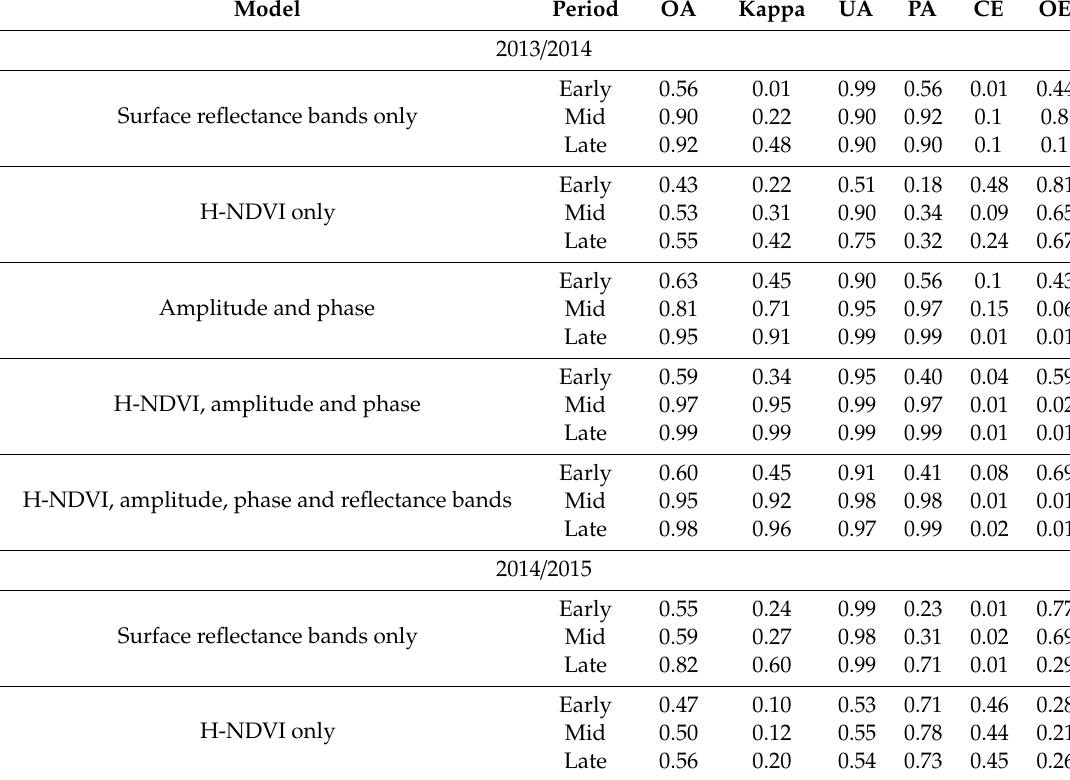
Table 3. Lists of overall Accuracy (OA), kappa, User’s Accuracy (UA), Producer’s Accuracy (PA), Omission Error (OE) and Commission Errors (CE) achieved from Leave-One-Season-Out Cross Validation (LOSOCV) based Random Forest (RF) classification applied to the validation